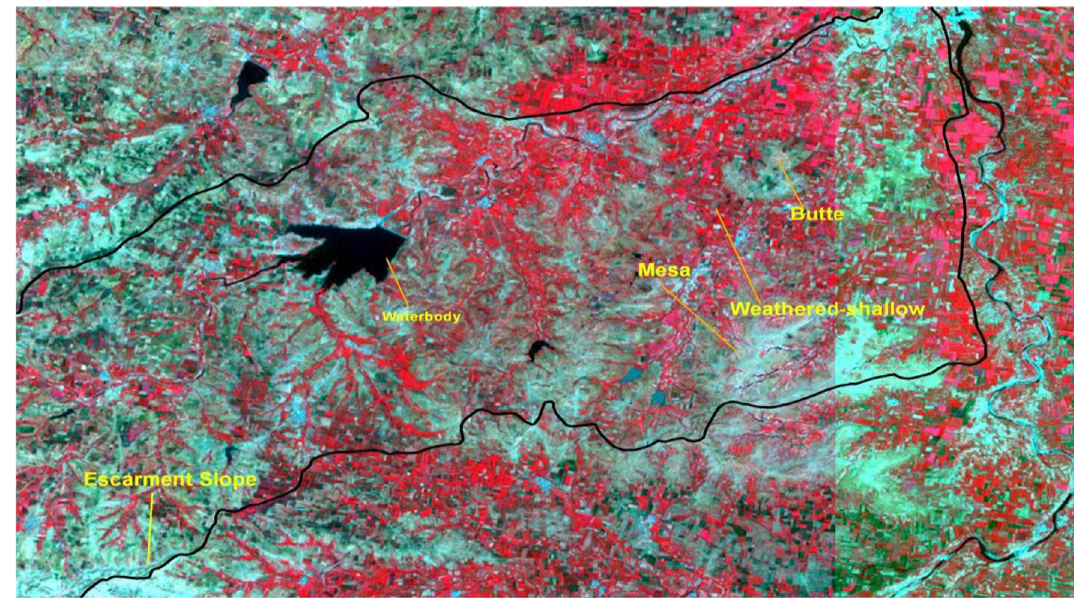
Fig. 3 Geomorphological landforms in study area